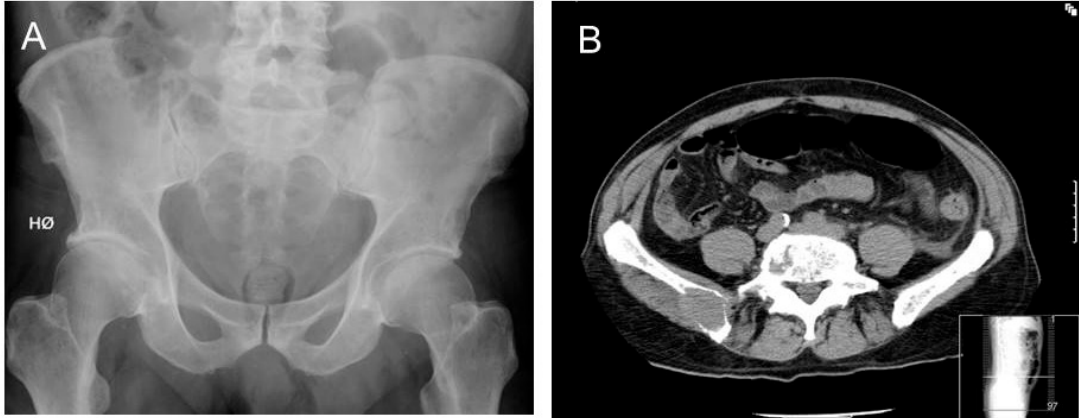
Figure 2. ( A ) A radiograph of the pelvis is assessed by the radiologist as normal. ( B ) CT of the pelvis in the same patient identifies a large lytic lesion with soft tumor in right crista region. Super-imposed air in the bowel hides the destruction on the conventional radiograph.